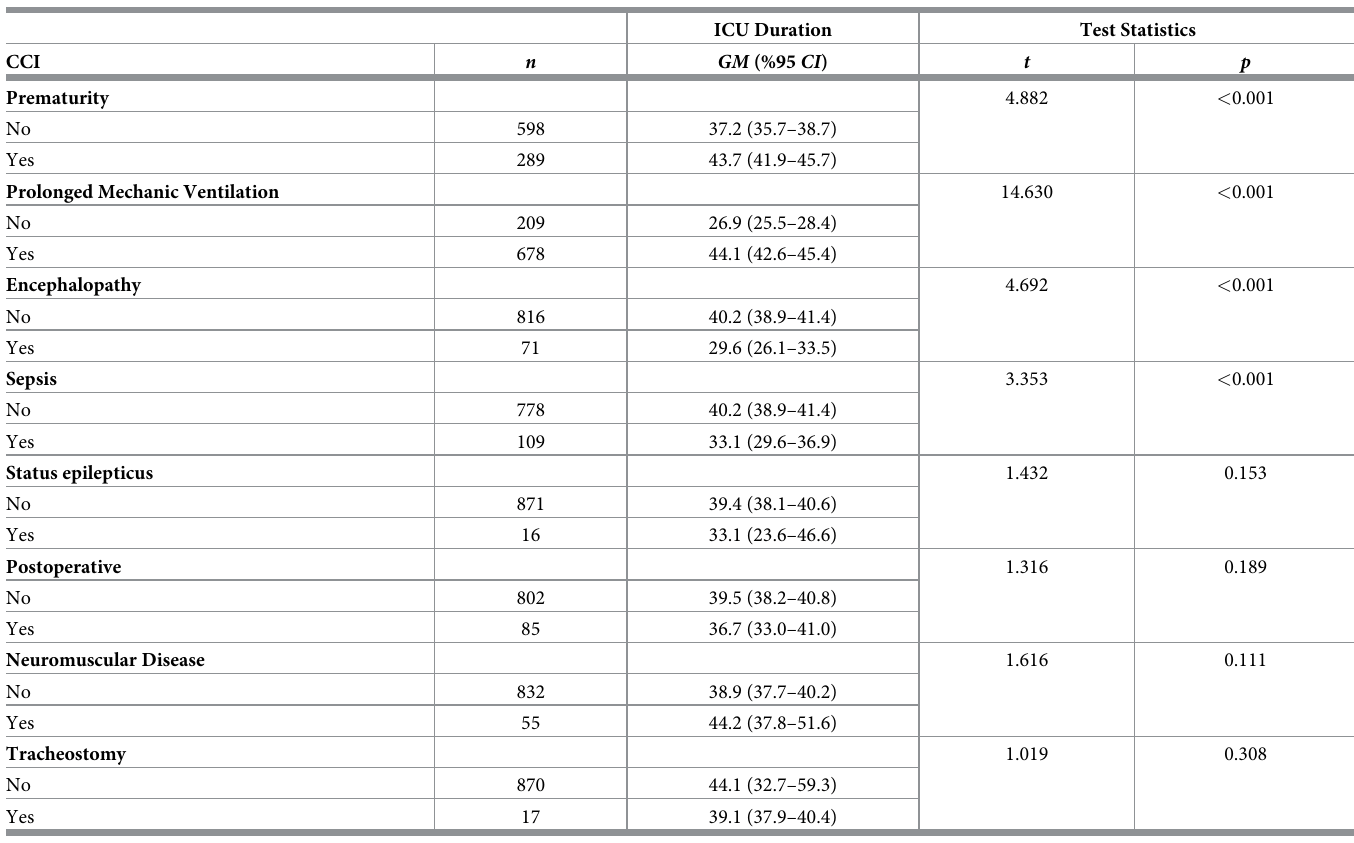
Table 5. Comparison of ICU stay by CCI